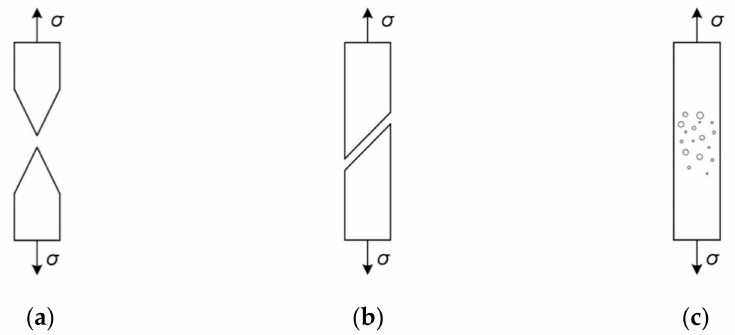
Figure 1. Ductile failure in metals: ( a ) necking; ( b ) shear; ( c ) development of